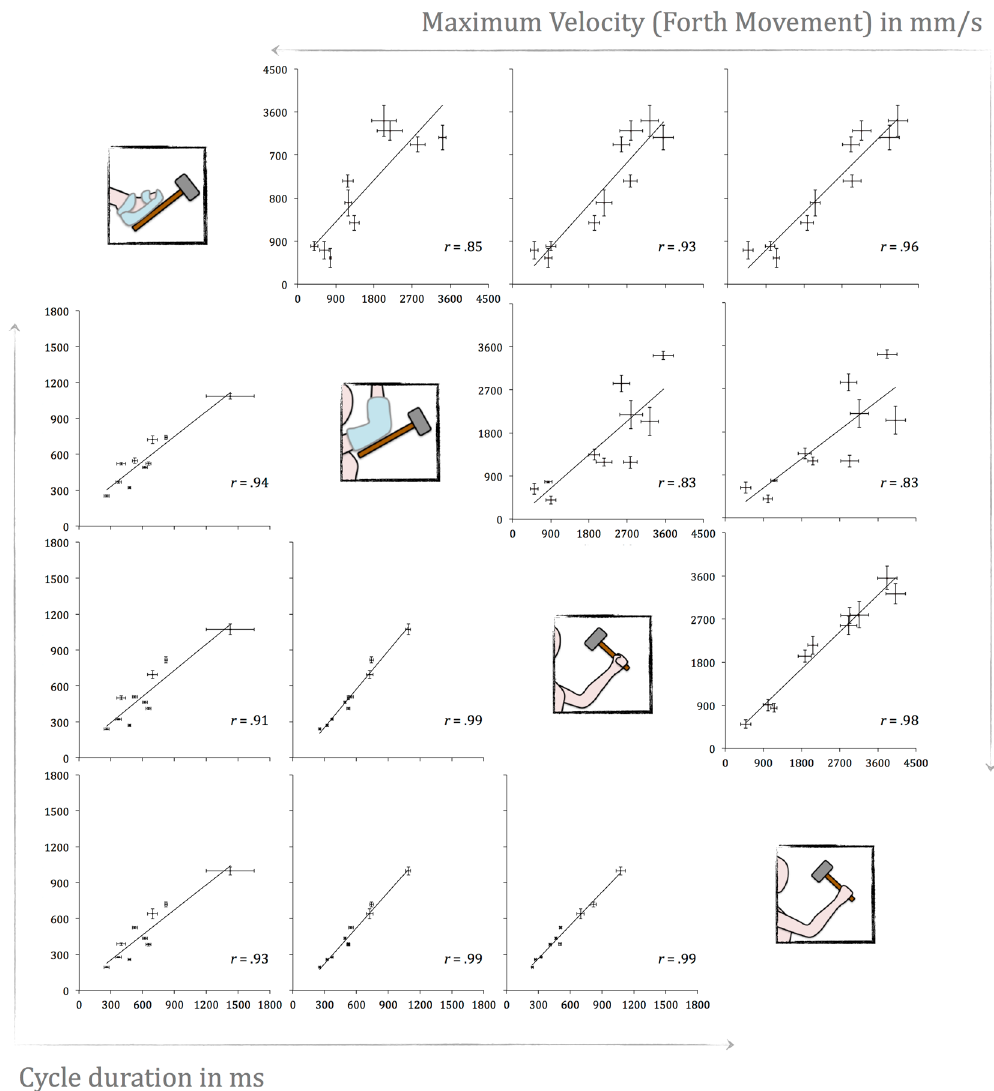
Figure 3. Correlations between the end-effectors for maximum velocity and cycle duration (Hammer condition). Bars represent individual standard errors. The four end-effectors are: Right foot, right elbow, left hand and right hand. Correlations are Pearson’s correlation coefficients. They all are significant (see Table